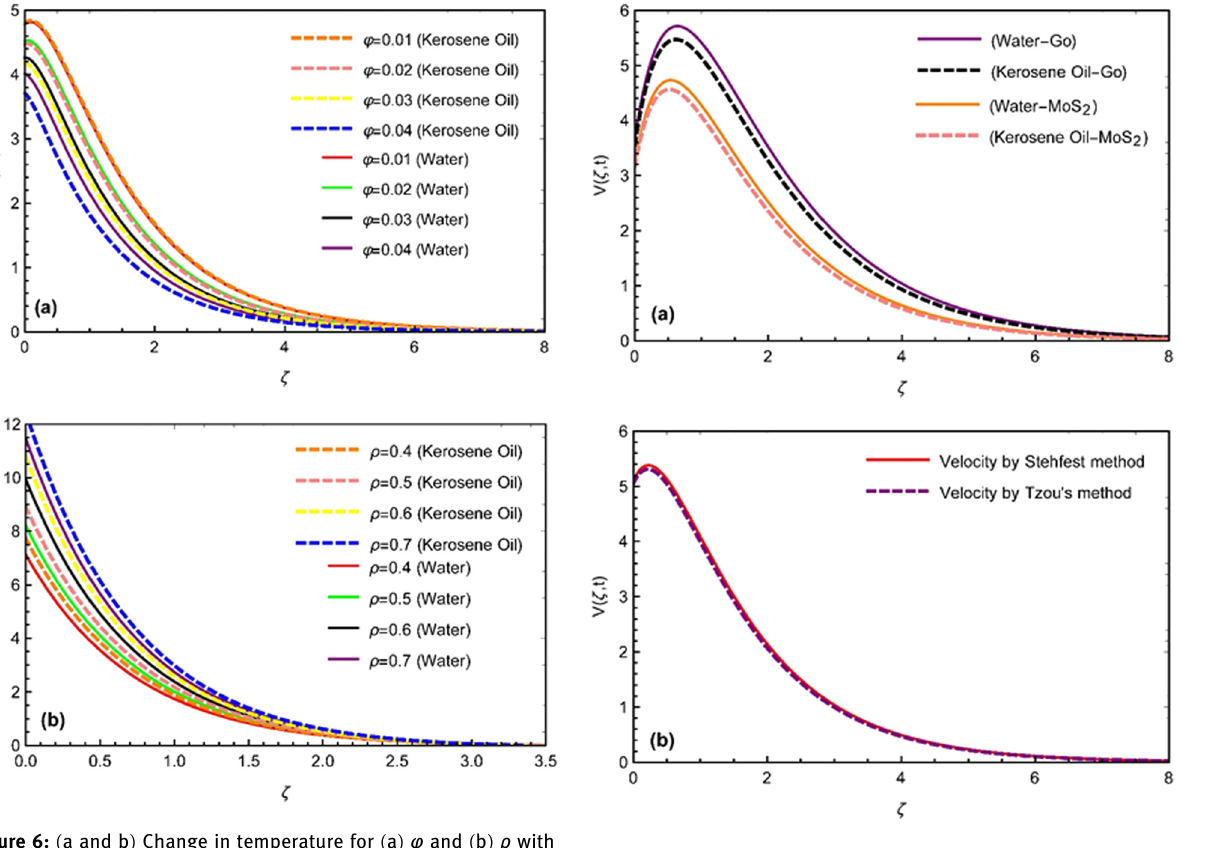
Figure 7: ( a and b ) Comparison of ( a ) di ff erent base fl uid parameters and ( b ) comparison of numerical schemes.